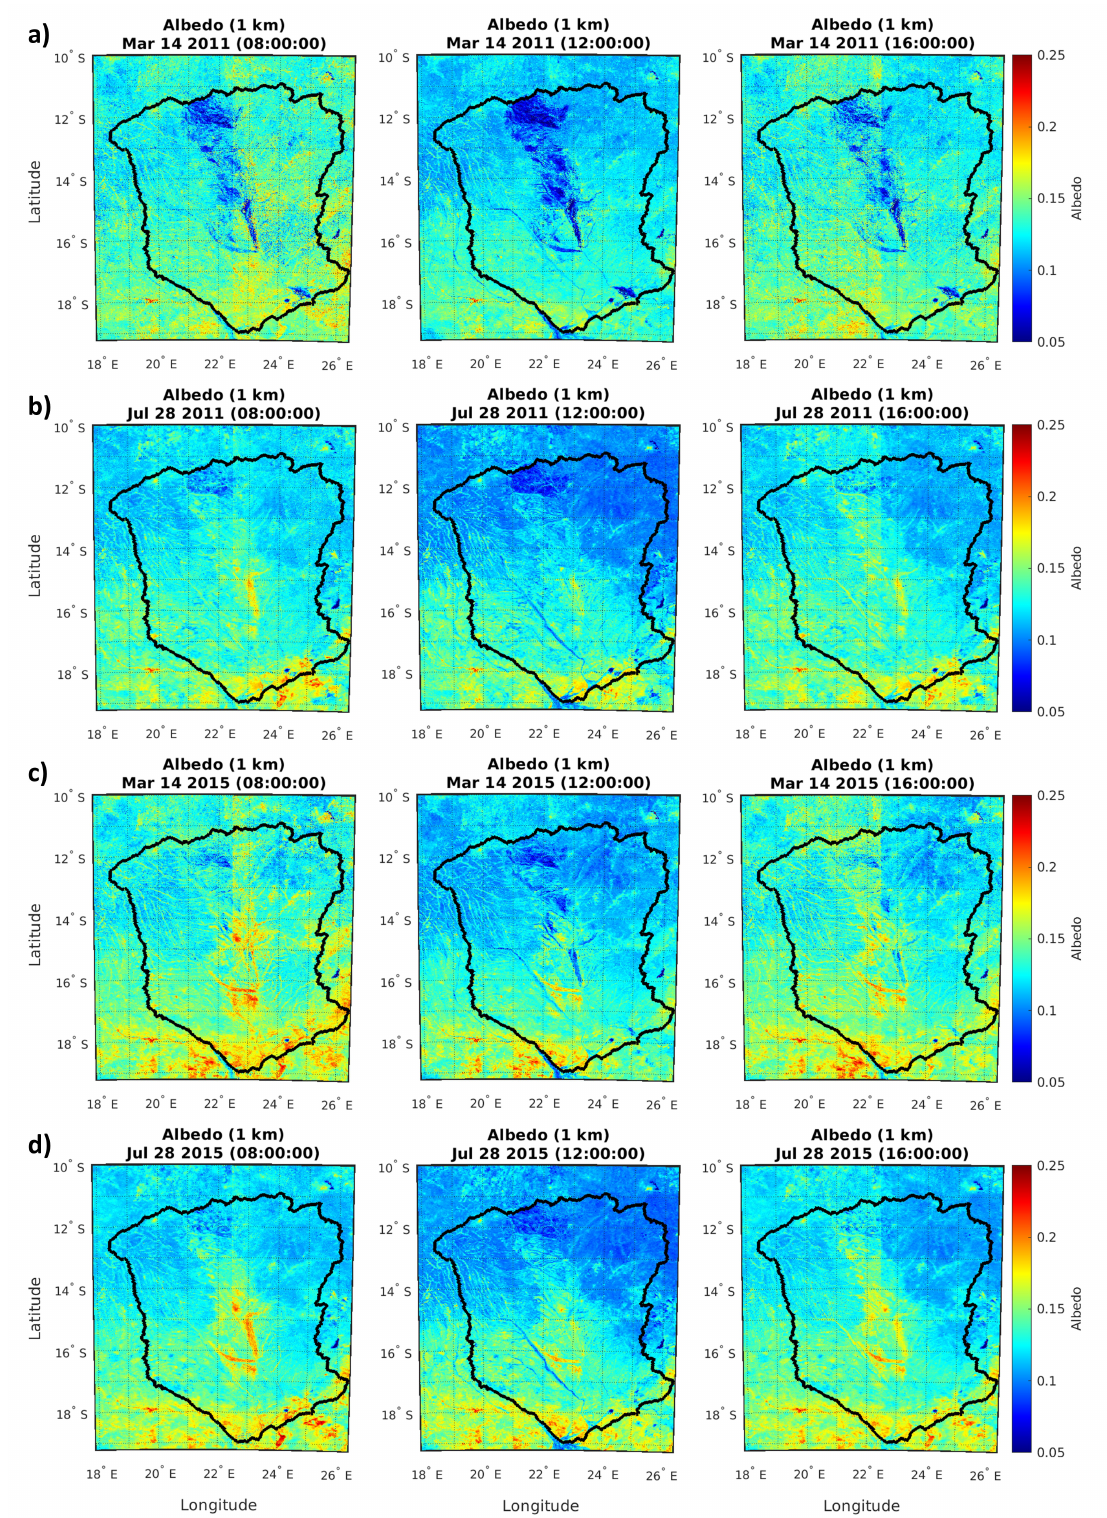
Figure 13. Spatial comparisons of ( a , b ) 2011 and ( c , d ) 2015 shortwave broadband albedo for morning, noon, and afternoon local times ( a , c ) just after the peak of the rainy season and ( b , d ) during the middle of the dry